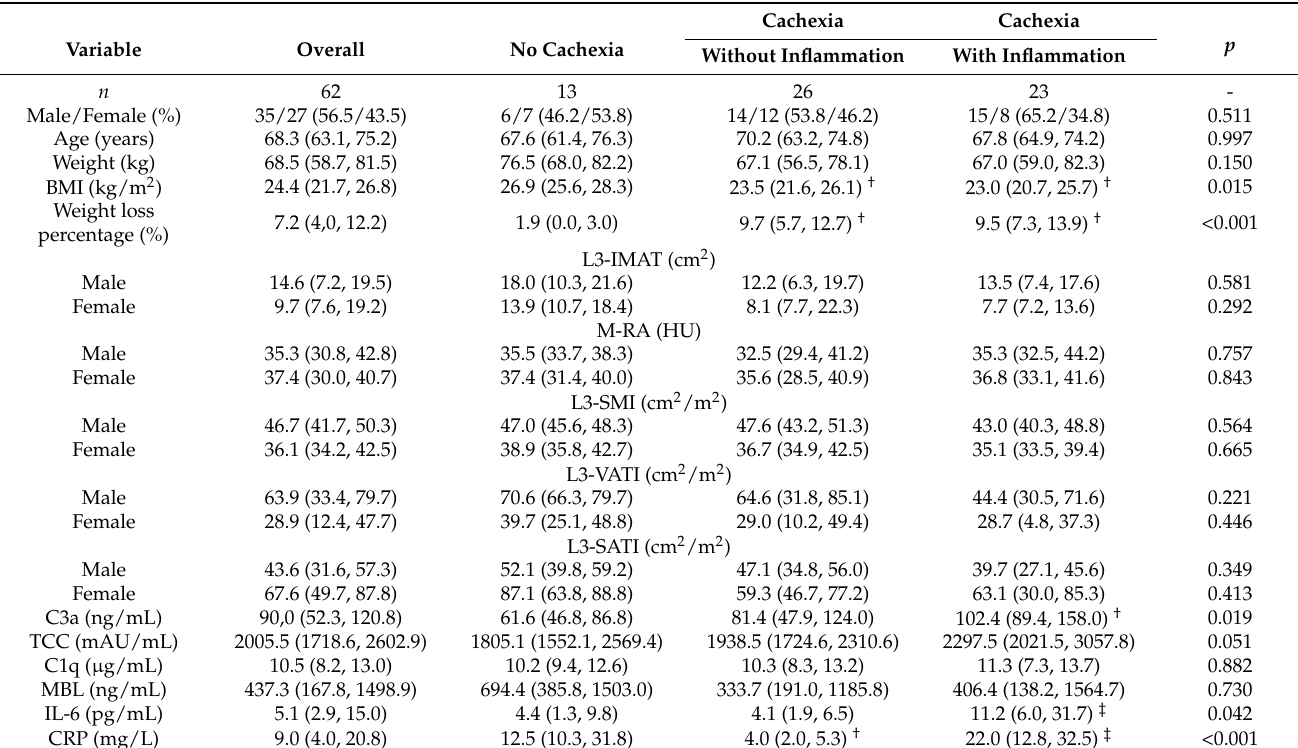
Table 1. General characteristics of patients with pancreatic tumor according to cachectic